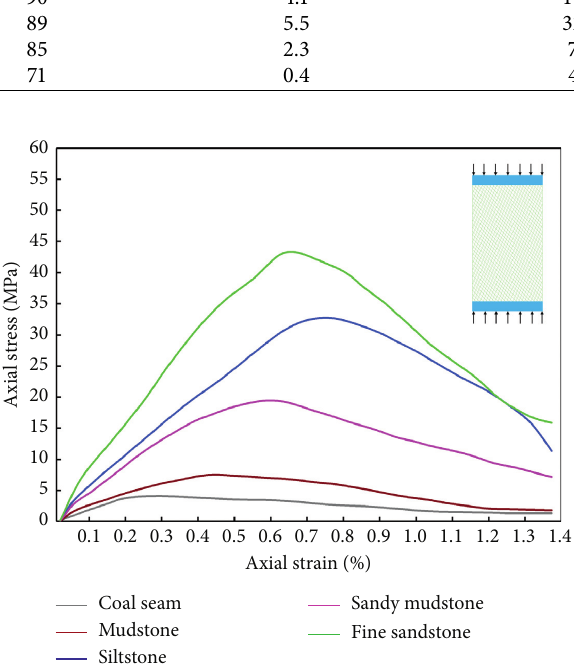
Figure 10: Axial stress-strain curves of the synthetic rock